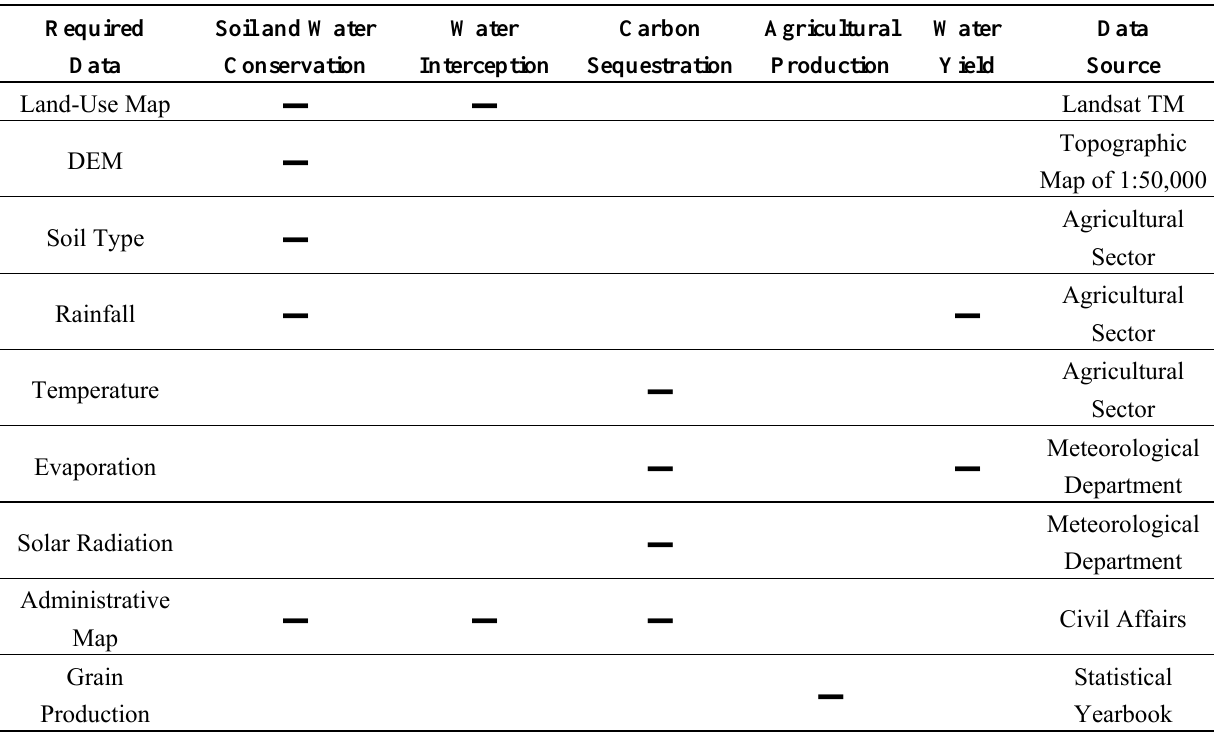
Table 1. Data and data